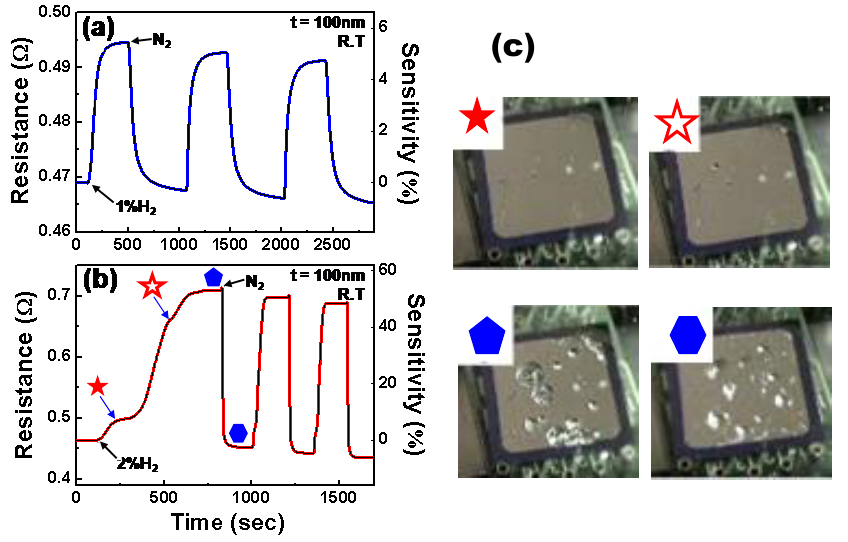
. (b) Sensitivity vs . H 2 2